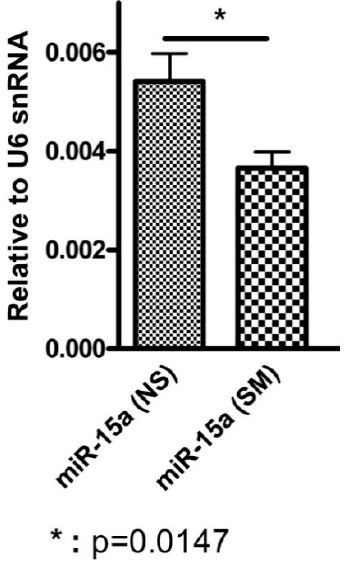
Figure 1. Differential expression of miR-15a by IUS exposure in postnatal mouse lung. NS are mice without intrauterine smoke exposure and SM are mice exposed to intrauterine smoke.